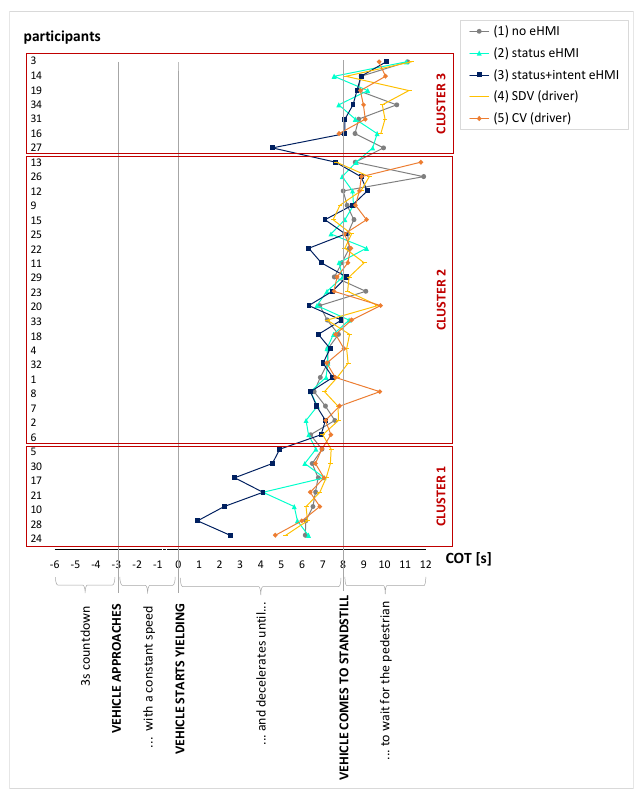
seem appropriate for this scheme. Information 2020 , 11 , 360